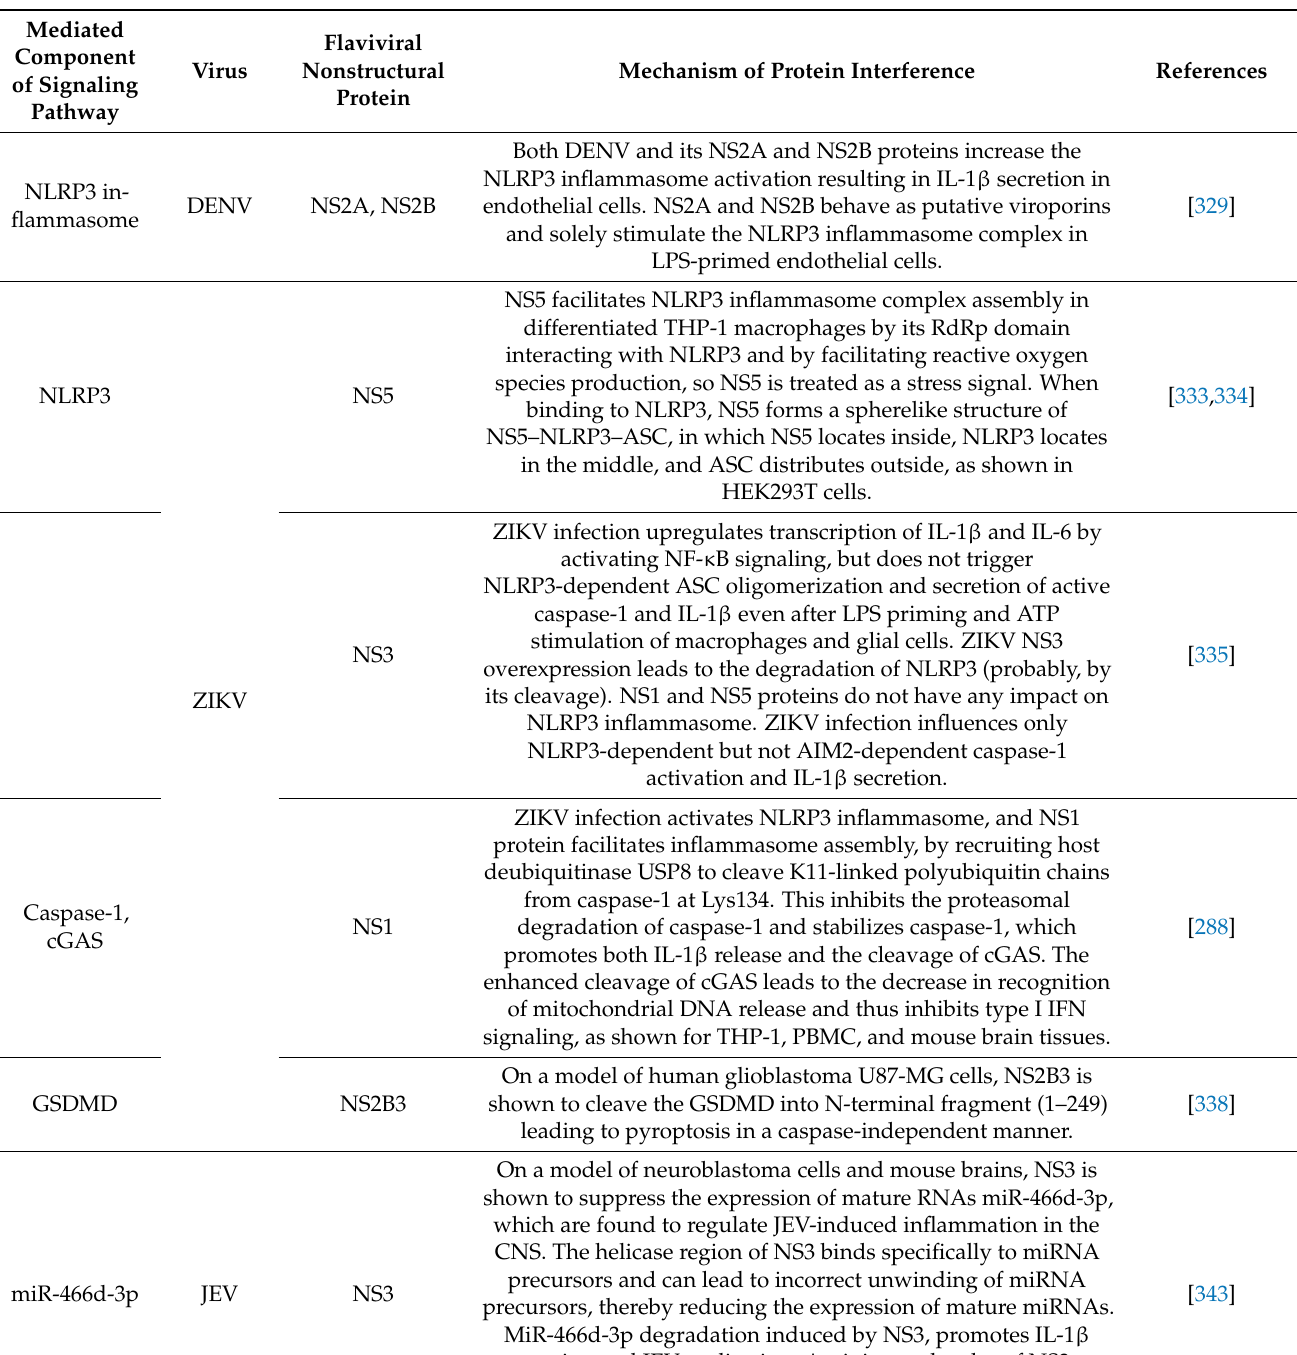
Table 6. Flaviviridae nonstructural proteins’ interference with NLR signaling and